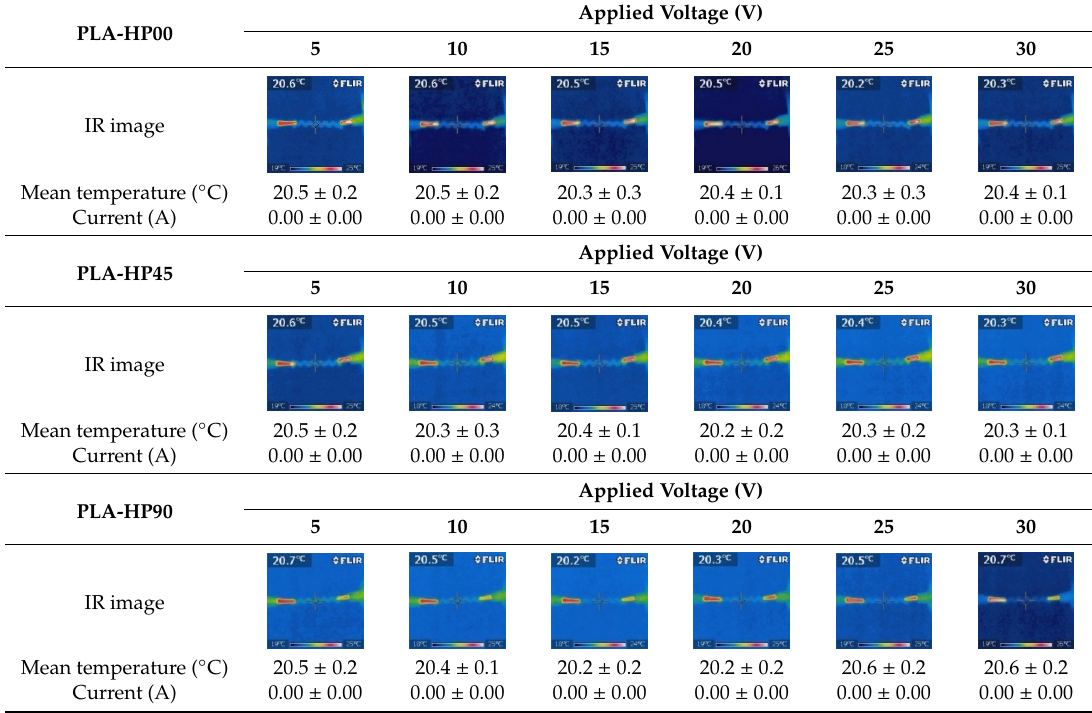
Table 6. IR images of PLA CFDM 3D-printed horseshoe pattern with different 3D printing directions.